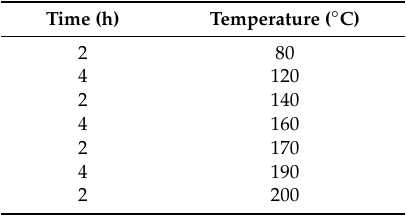
Table 2. Cure temperature profiles of S 5 , E 10 , EM 10 , and M 10